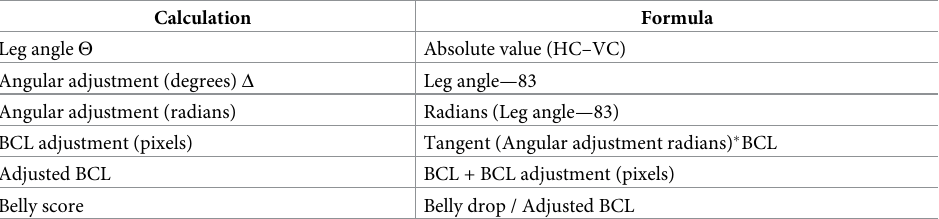
Table 2. Formulas used in Excel spreadsheet to derive belly scores for Lycaon pictus from morphometric